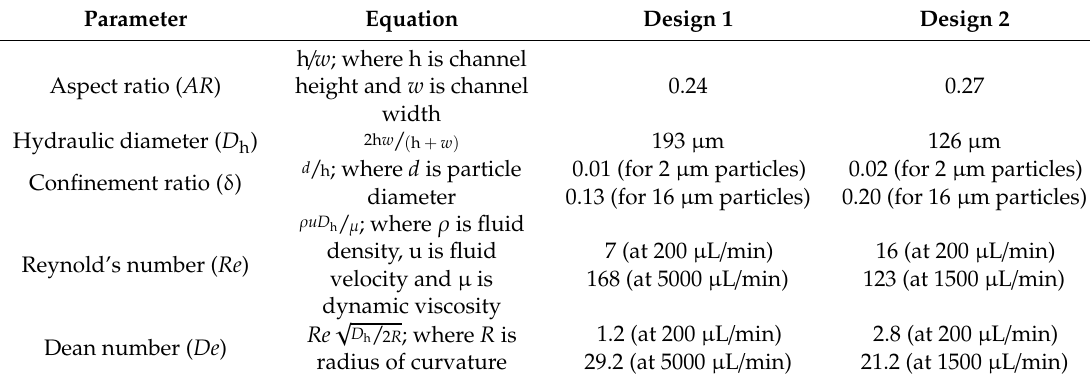
Table 1. Important parameters for determining the separation e ffi ciency of spiral